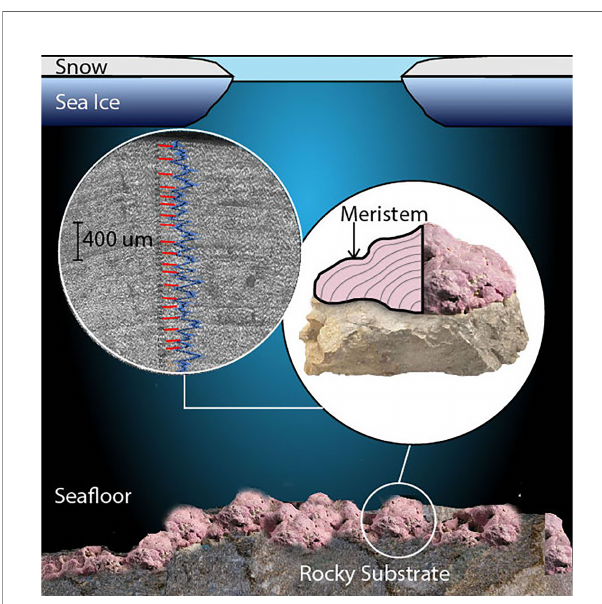
FIGURE 1 | Most of Clathromorphum compactum ’ s growth occurs during open water conditions in summer months, while dark sea ice covered winter conditions only allow limited growth producing bands of smaller heavily calci fi ed (dark grey) cells. Colonies develop on rocky surfaces at 10-30 m depths. Continuous Mg/Ca measurement transect (blue), along axis of growth superimposed onto high-resolution sample image. Annual Mg/Ca minima shown with red line markers. Modi fi ed from Leclerc et al. (2021). FIGURE 2 | High-resolution sample image and laser transects used in this